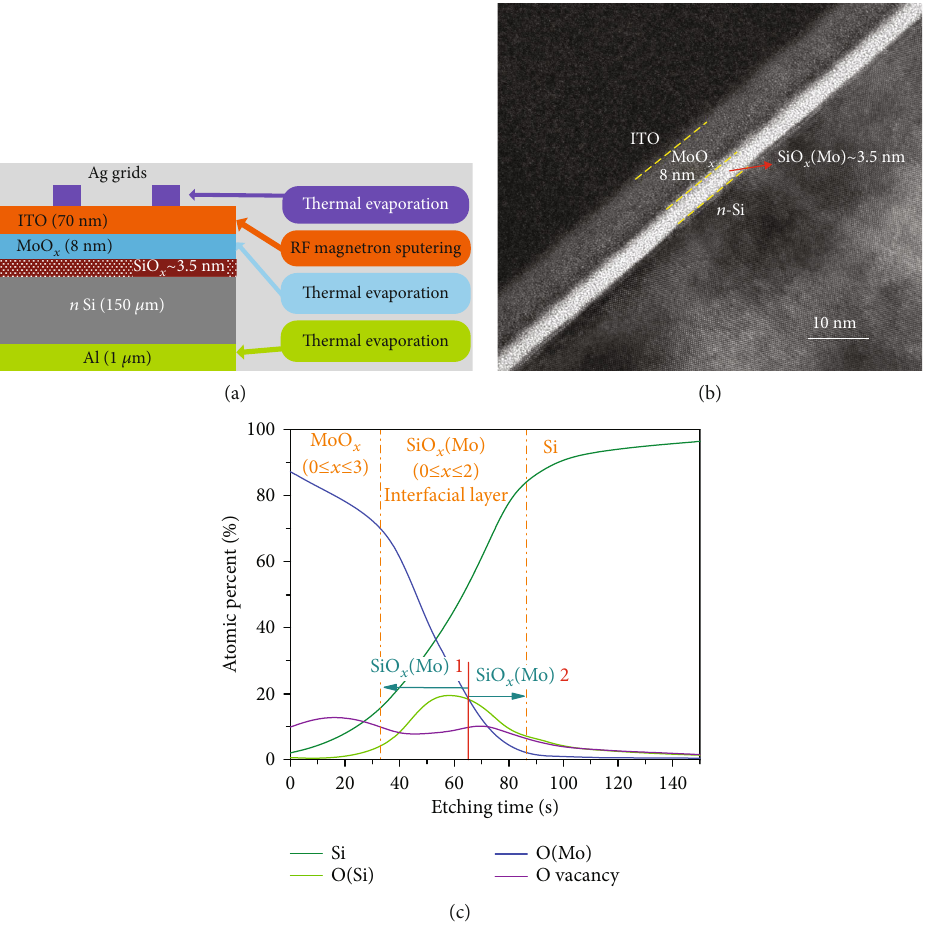
Figure 1: (a) Schematic of the MSHJ solar cell structure. (b) The cross-sectional HRTEM image of the interfacial layer of the MoO Relative atomic percentage distribution of O (Si) (denotes O-Si bond), O (Mo) (denotes O-Mo bond), and Si with an increasing etching time fi lm and the n -Si for the transitional region between the MoO x